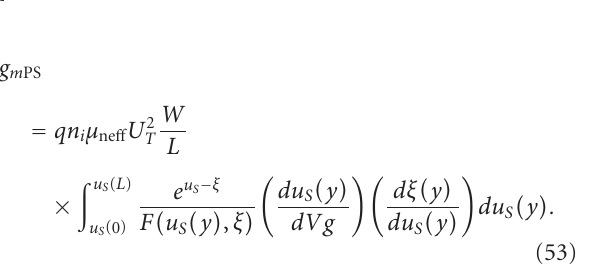
Figure 17: Transconductance versus Vg ( L = 90nm; W/L =